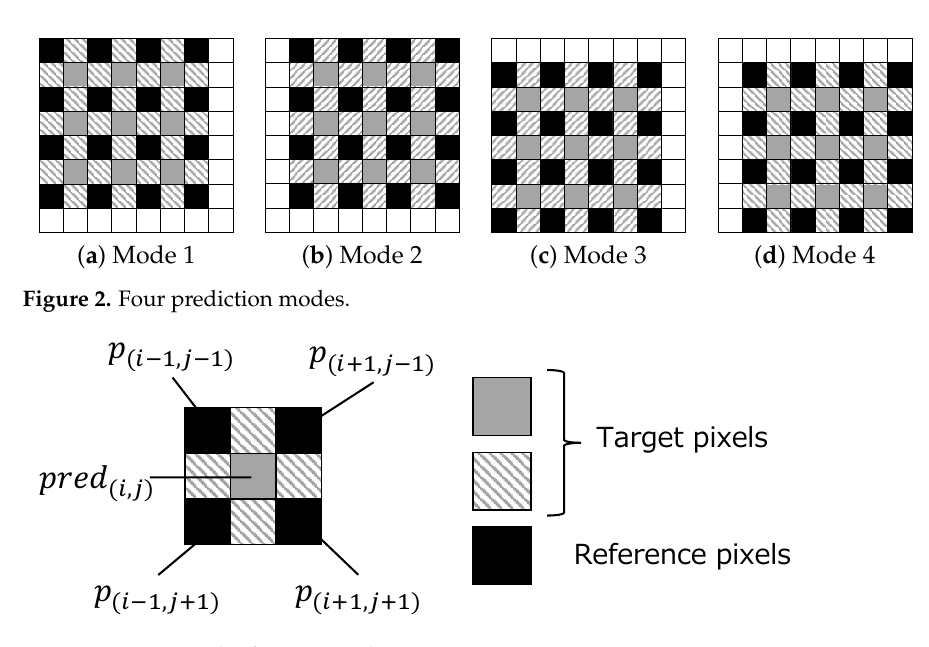
Figure 3. Target and reference pixels in I 1